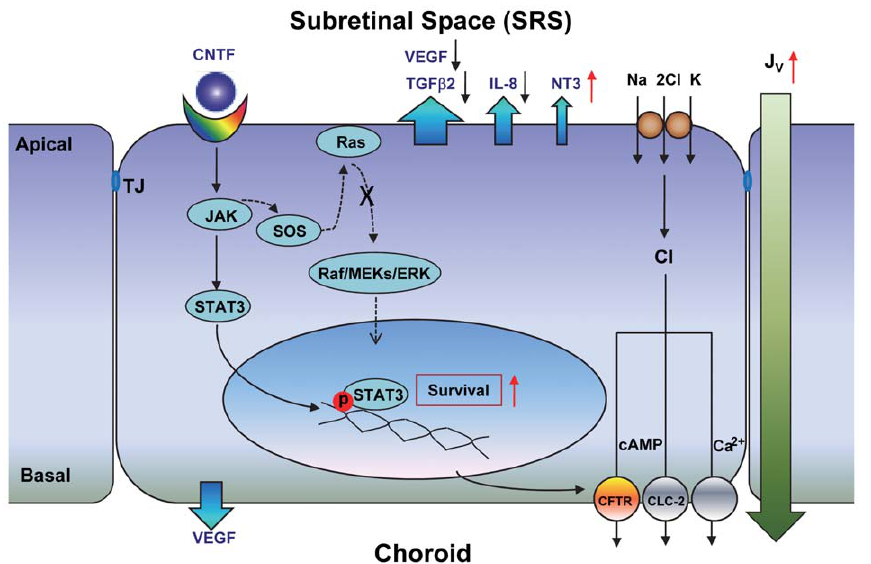
Figure 12. Schematic diagram of CNTF signaling in human RPE. Human RPE constitutively secretes a range of growth factors, cytokines, and neurotrophic factors, including VEGF, IL8, TGF b 2, CNTF, and NT3 (blue arrows) to the apical bath. In addition, retinal damage can increase CNTF release toward the subretinal space. CNTF binding to its receptors at the RPE apical membrane activates JAK/STAT3 signaling and promotes RPE survivability. It also decreases VEGF, IL8, and TGF b 2 secretion into the apical bath and increases apical NT3 secretion along with fluid absorption ( J V ), mediated by the activation of basolateral CFTR chloride channels.